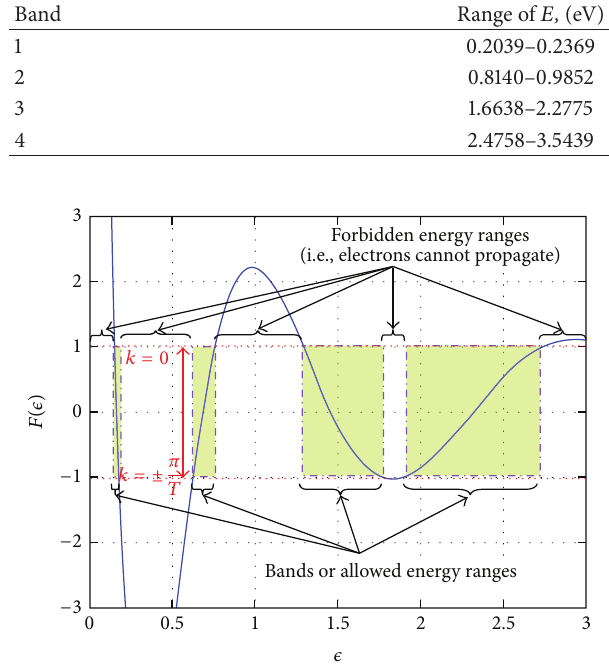
Figure 2: The left-hand side of (9), (𝜖) , against 𝜖 at fixed values of 𝜇 and 𝐴 . This graph shows allowed and forbidden electron energy bands for the simple cubic QD with the quantum dot width 𝐿 4.5